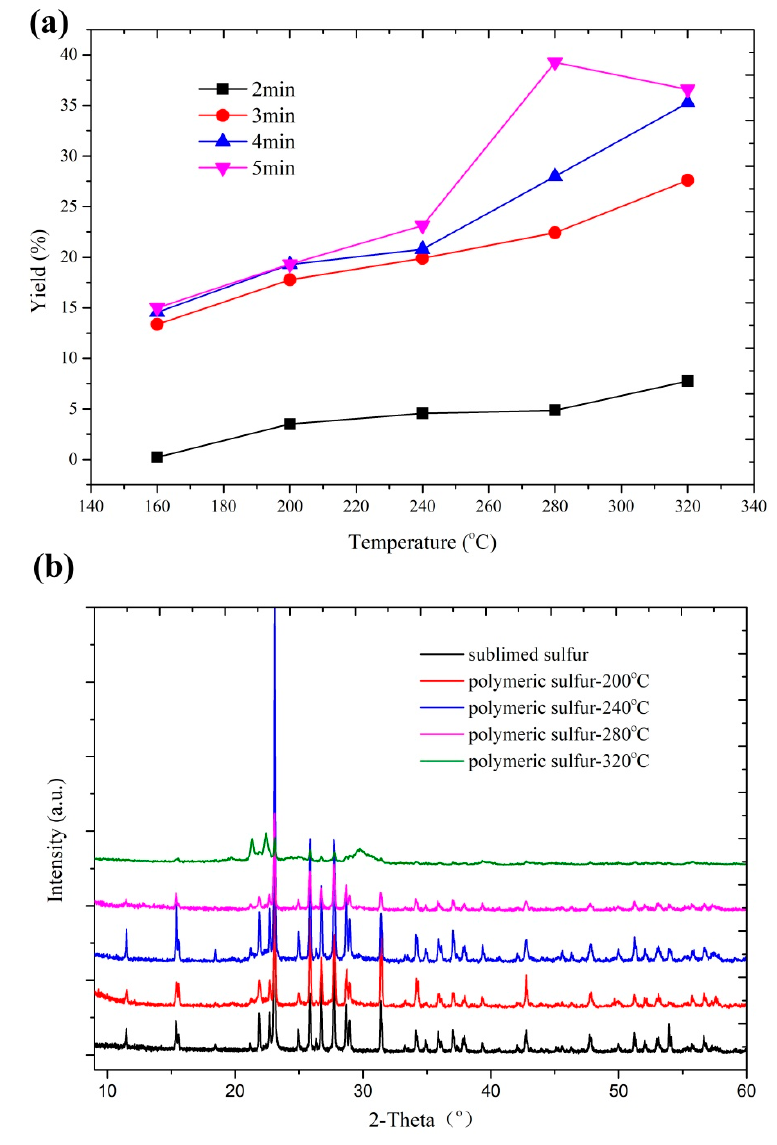
Figure 2. ( a ) Yield of the polymeric sulfur at different temperatures and reaction times. ( b ) XRD patterns of the commercial sublimed sulfur and the polymeric sulfur prepared at various temperatures for 4 min.